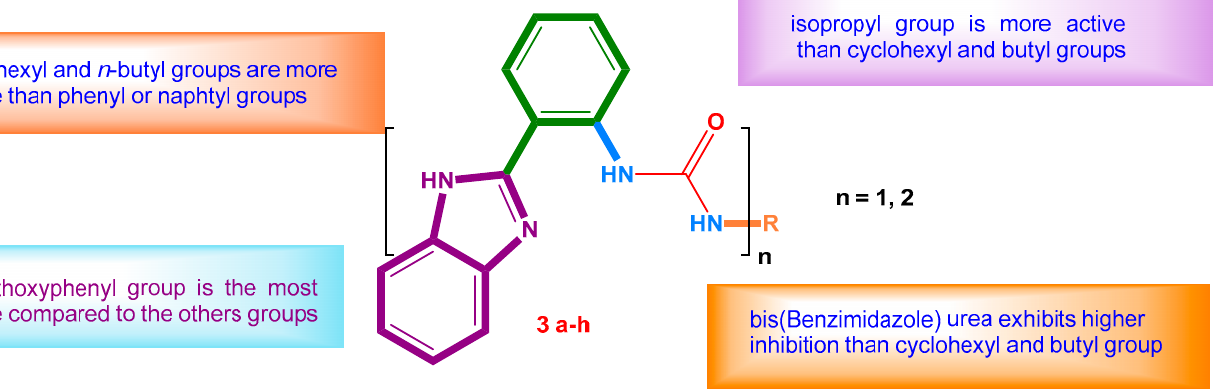
Figure 4 . Structure-activity relationships related to benzimidazole urea derivatives 3a-h .